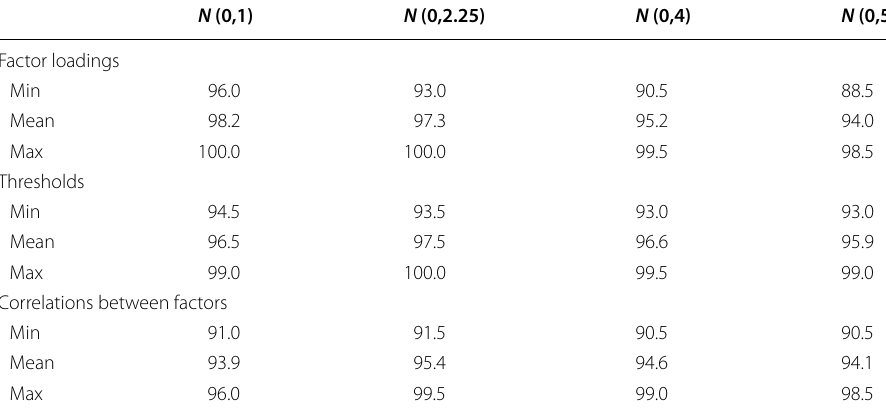
Table 3 95 % coverage in the simulation